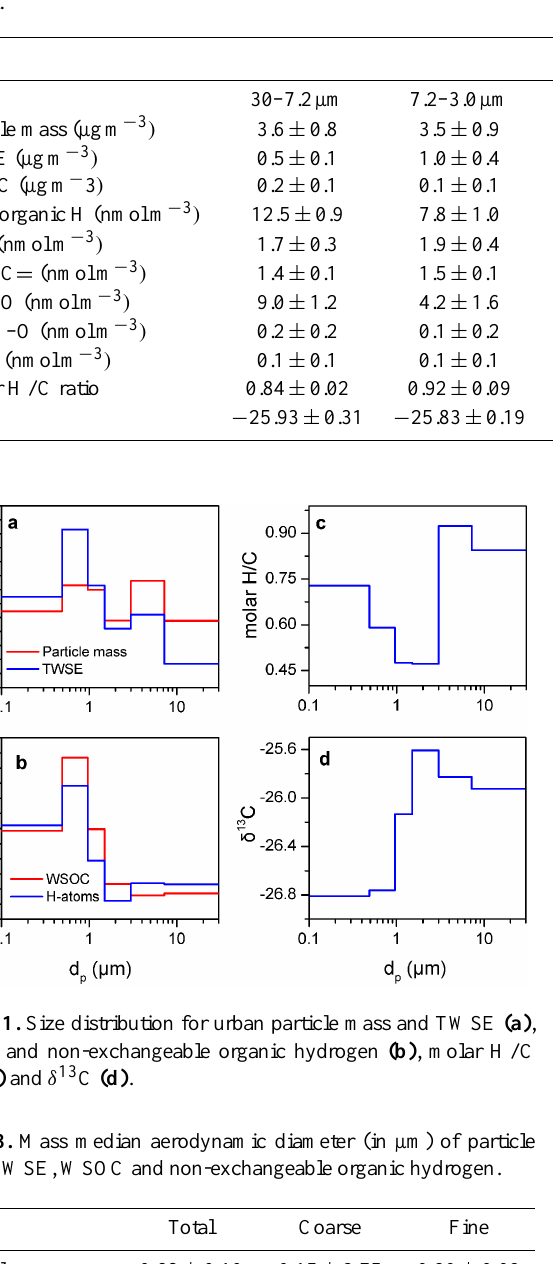
Table 2. Particle mass, TWSE, WSOC and non-exchangeable organic hydrogen concentrations and δ 13 C at each impactor stage for urban aerosol.